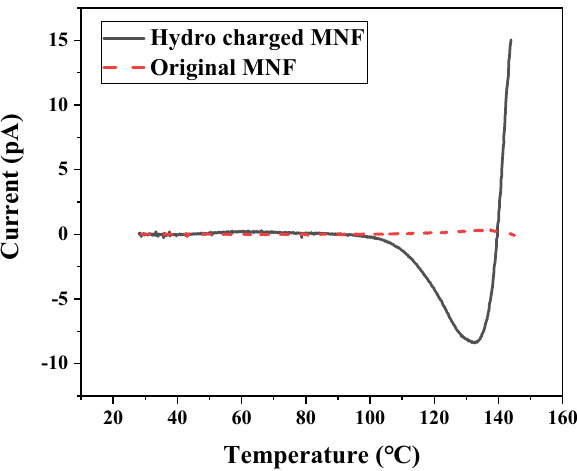
Figure 7. The TSD spectra of MNF before and after triboelectric charging treatment.